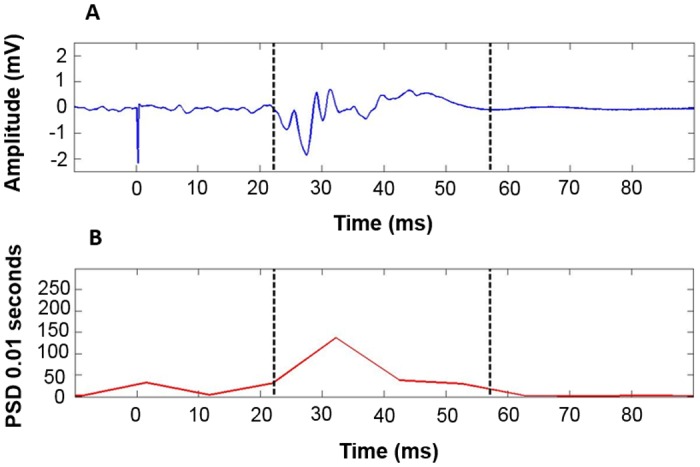
A) Windowed signal for choosing template of a single trial (with estimated MEP onset and offset template). B) Spectrogram for choosing template of a single trial. PDS = power spectral density, mV = millivolt, ms = milliseconds.